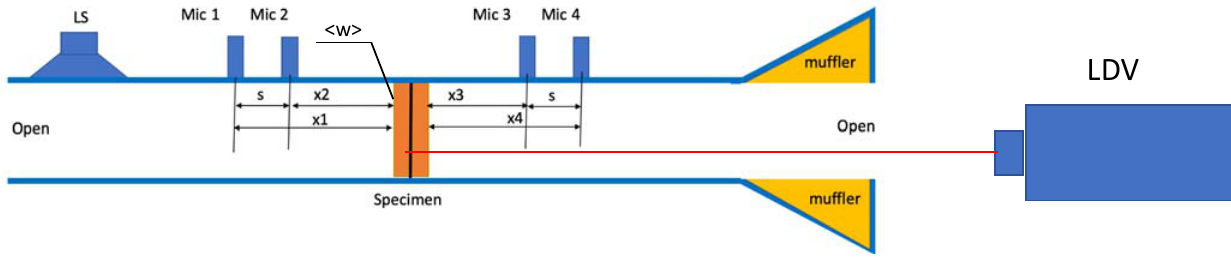
Figure 6. Scheme of measurement setup with LDV scanning head. Where Mic 1–4 denote the microphone positions, s is distance between microphone positions, x 1 – x 4 are distance of the microphones to the specimen surface, < w > is the spatially averaged displacement measured at the specimen surface, LS is loudspeaker, LDV is laser doppler vibrometer.